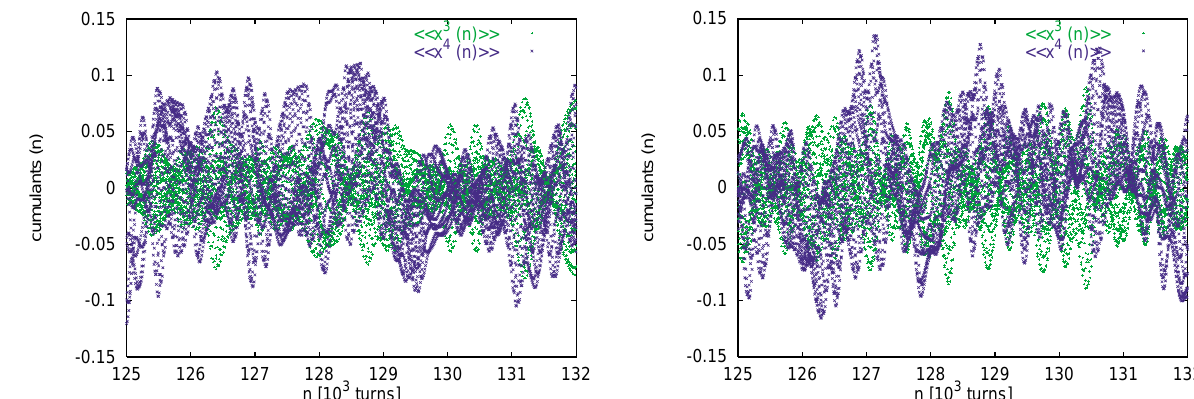
FIG. 2. (Color) Evolution of the cumulants of order 3 and 4 in the collision of two distributions of N (cid:1) 10 4 macroparticles, for the smallest amplitude of centroid oscillation of order d (cid:1) 0.01 (left) and for an initial offset of d (cid:1) 0.1 (right). The deviation from Gaussian shape is dominated by statistical fluctuations due to the finite number of macroparticles and is independent of the amplitude of centroid oscillation. In a Gaussian distribution, the cumulants of order higher than 2 are exactly equal to zero. To quantify